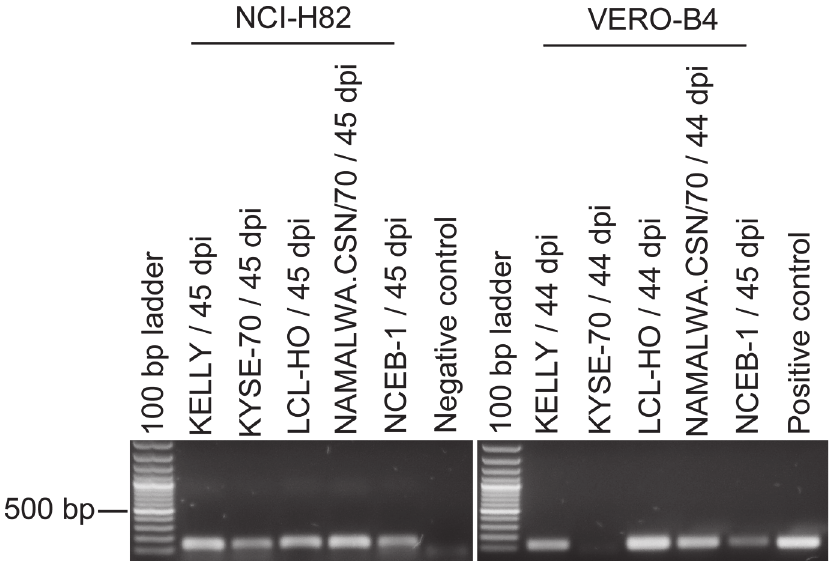
Fig 9. Detection of RT activity in cell lines infected with MLV of contaminated cell lines by PERT assay. Cell culture supernatants of the infected cell lines NCI-H82 and VERO-B4 were harvested after 45 and 44 days after infection, respectively. MS2 phage RNA was reverse transcribed with an MS2-specific primer and the MLV derived RT of the samples in the presence of MnCl 2 . The cDNA was then amplified with a second MS2-specific primer applying PCR. The signals of the cell lines infected with LCL-HO supernatant may potentially be ascribed to the activity of SMRV derived RT. dpi: days post infection.